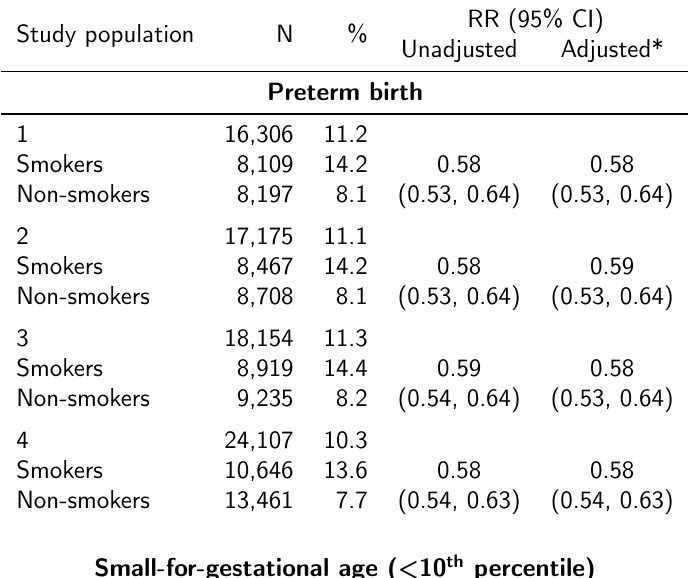
Table 4: Frequency of perinatal outcomes at the time of birth of all Aboriginal mothers by smoking status during pregnancy and the estimated relative risk (RR) with 95% confidence intervals (95%